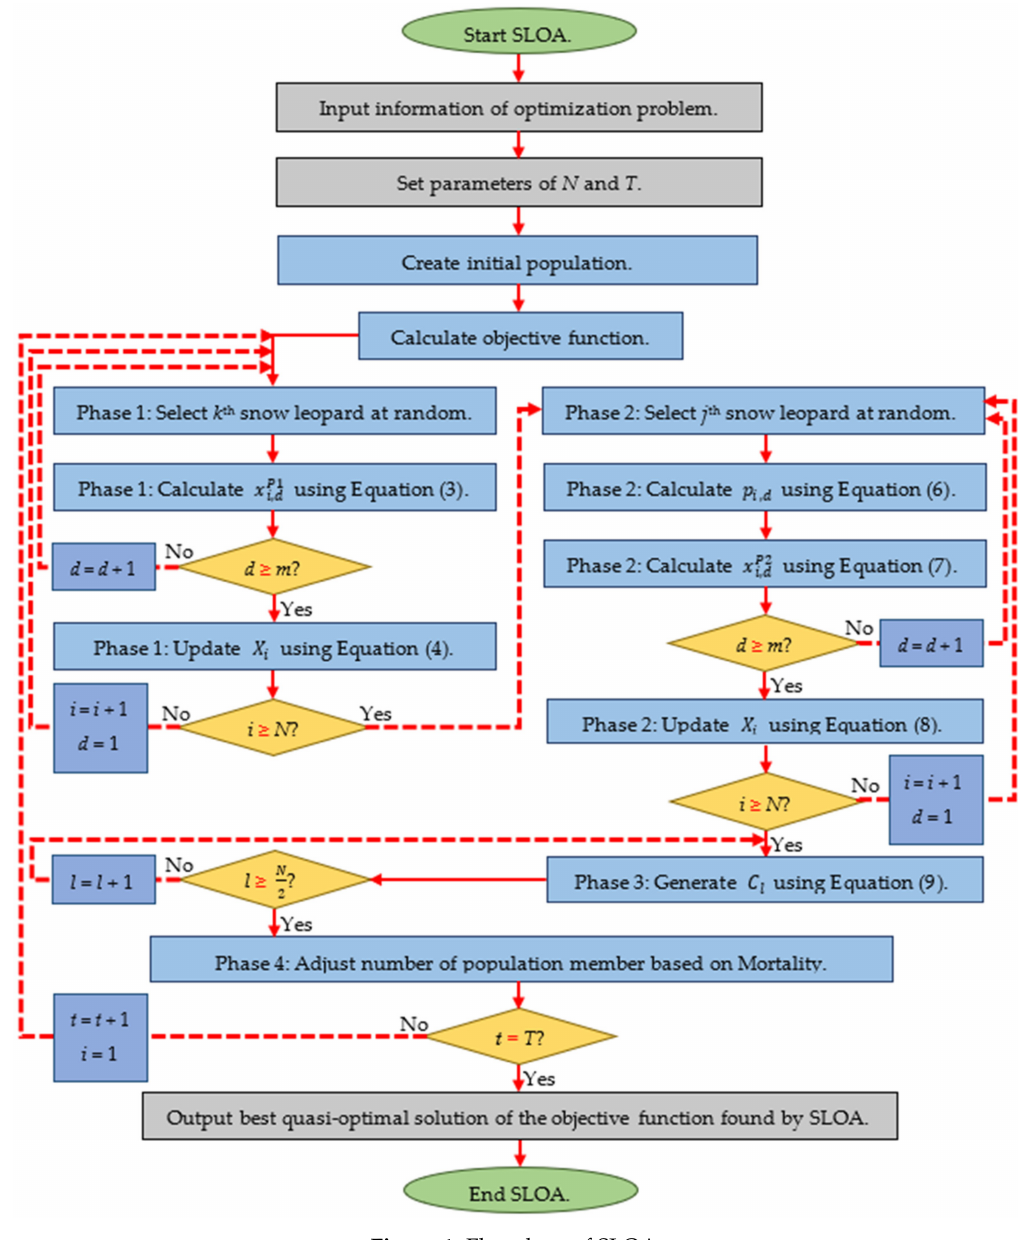
Figure 1. Flowchart of